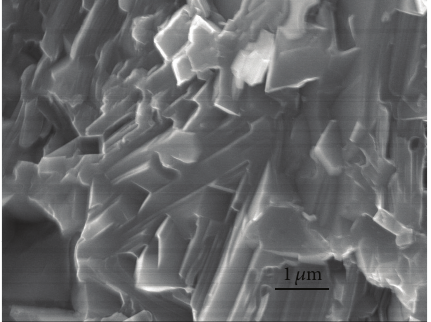
Figure 7: Fracture surface after crack bridging or pull-out of TiB 2 platelet.